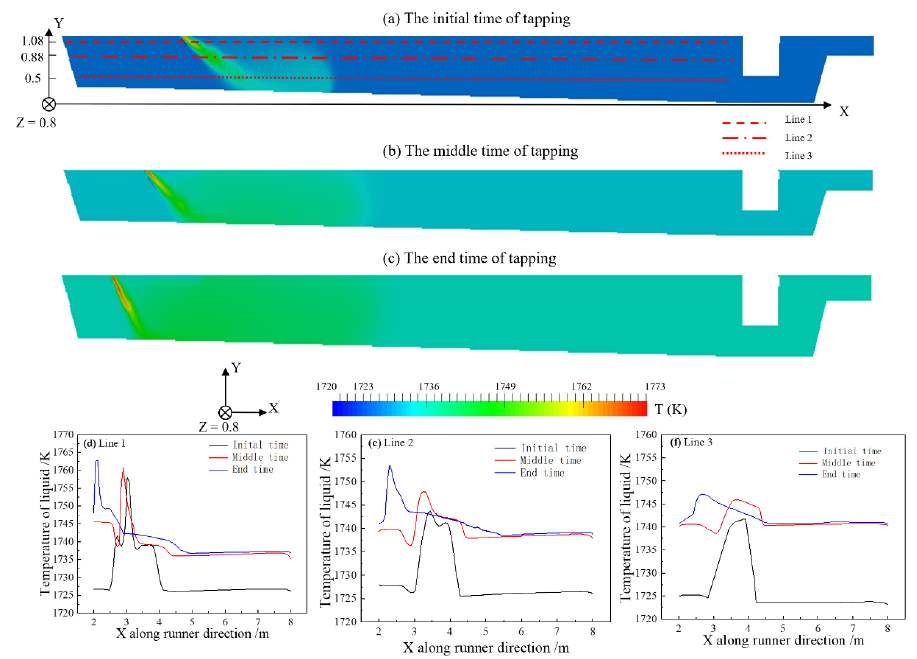
Figure 6. Temperature distribution of hot metal on the center plane (cf. Figure 4) at three different times: ( a ) Initial; ( b ) Middle; ( c ) End and different Y-axis height: ( d ) 1.08 m; ( e ) 0.88 m; (f) 0.5 m.